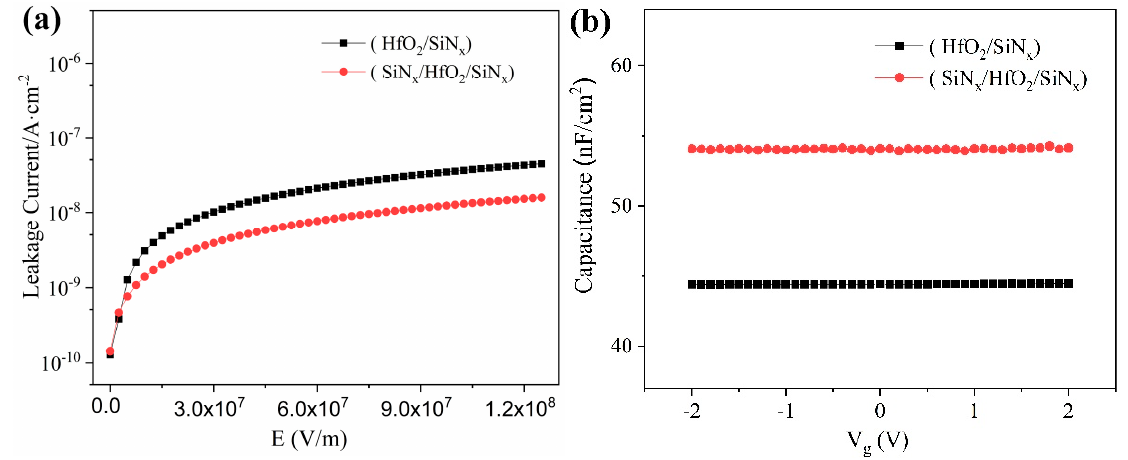
Figure 5. The electrical characteristics of HS and SHS dielectrics-based a-IGZO TFT. ( a ) J-E characteristics; ( b ) C-V characteristics (AC frequency is 1 MHz).